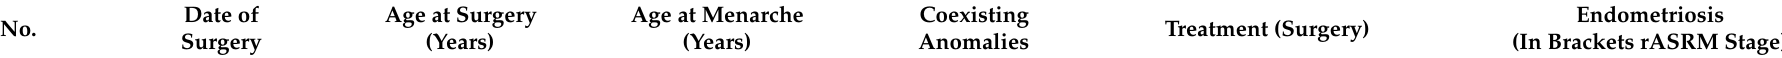
Table 2. Characteristic of 35 patients diagnosed with congenital obstructive anomalies of the genital tract in the presence of menstrual cycles. The anomalies are categorized according to the European Society of Human Reproduction and Embryology and the European Society for Gynecological Endoscopy (ESHRE/ESGE) classification system of female genital tract congenital anomalies [10], and the American Society for Reproductive Medicine Müllerian anomalies classification (ASRM MAC) 2021 [11]. Endometriosis is staged according to the revised ASRM (rASRM) classification of endometriosis [12]. OHVIRAS: obstructed